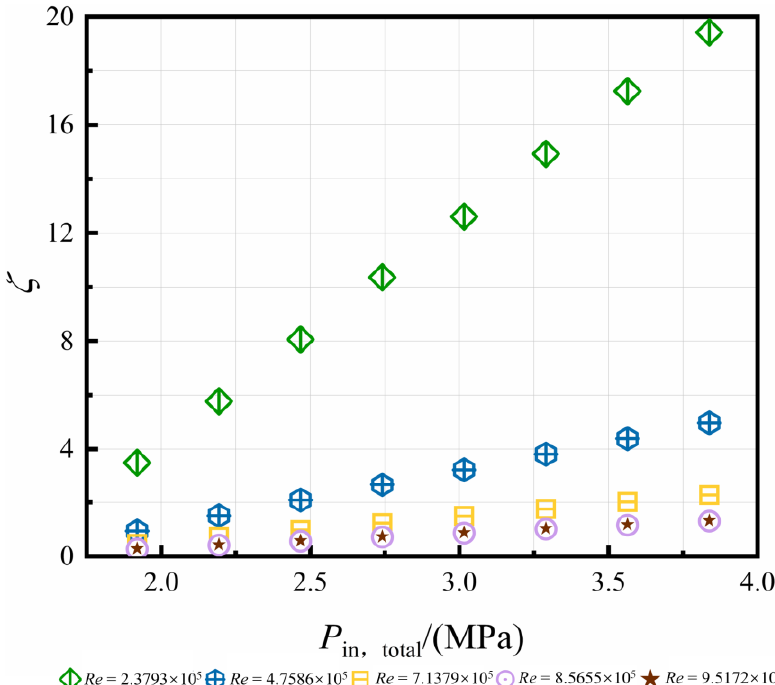
Figure 8. Distribution of ζ at different Re .